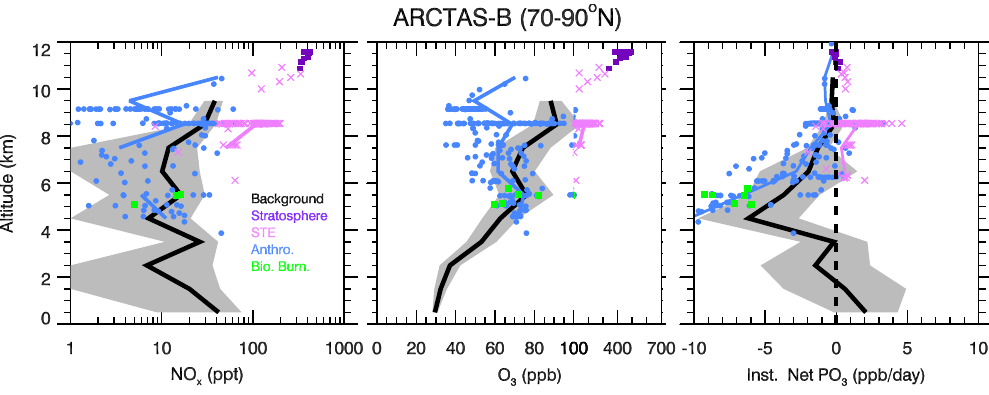
Fig. 13. Vertical profiles of (a) NO x , (b) O 3 , and (c) instantaneous NP(O 3 ) between 70 ◦ N–90 ◦ N during ARCTAS-B. Similar to Fig. 10, the background air is shown in black with individual air masses highlighted in color: stratosphere (purple), stratosphere-troposphere mixed (lilac), anthropogenic pollution (blue), biomass burning (green). mission ( 1 O 3 ∼ 2–15 ppb) (Tang et al., 2003), the